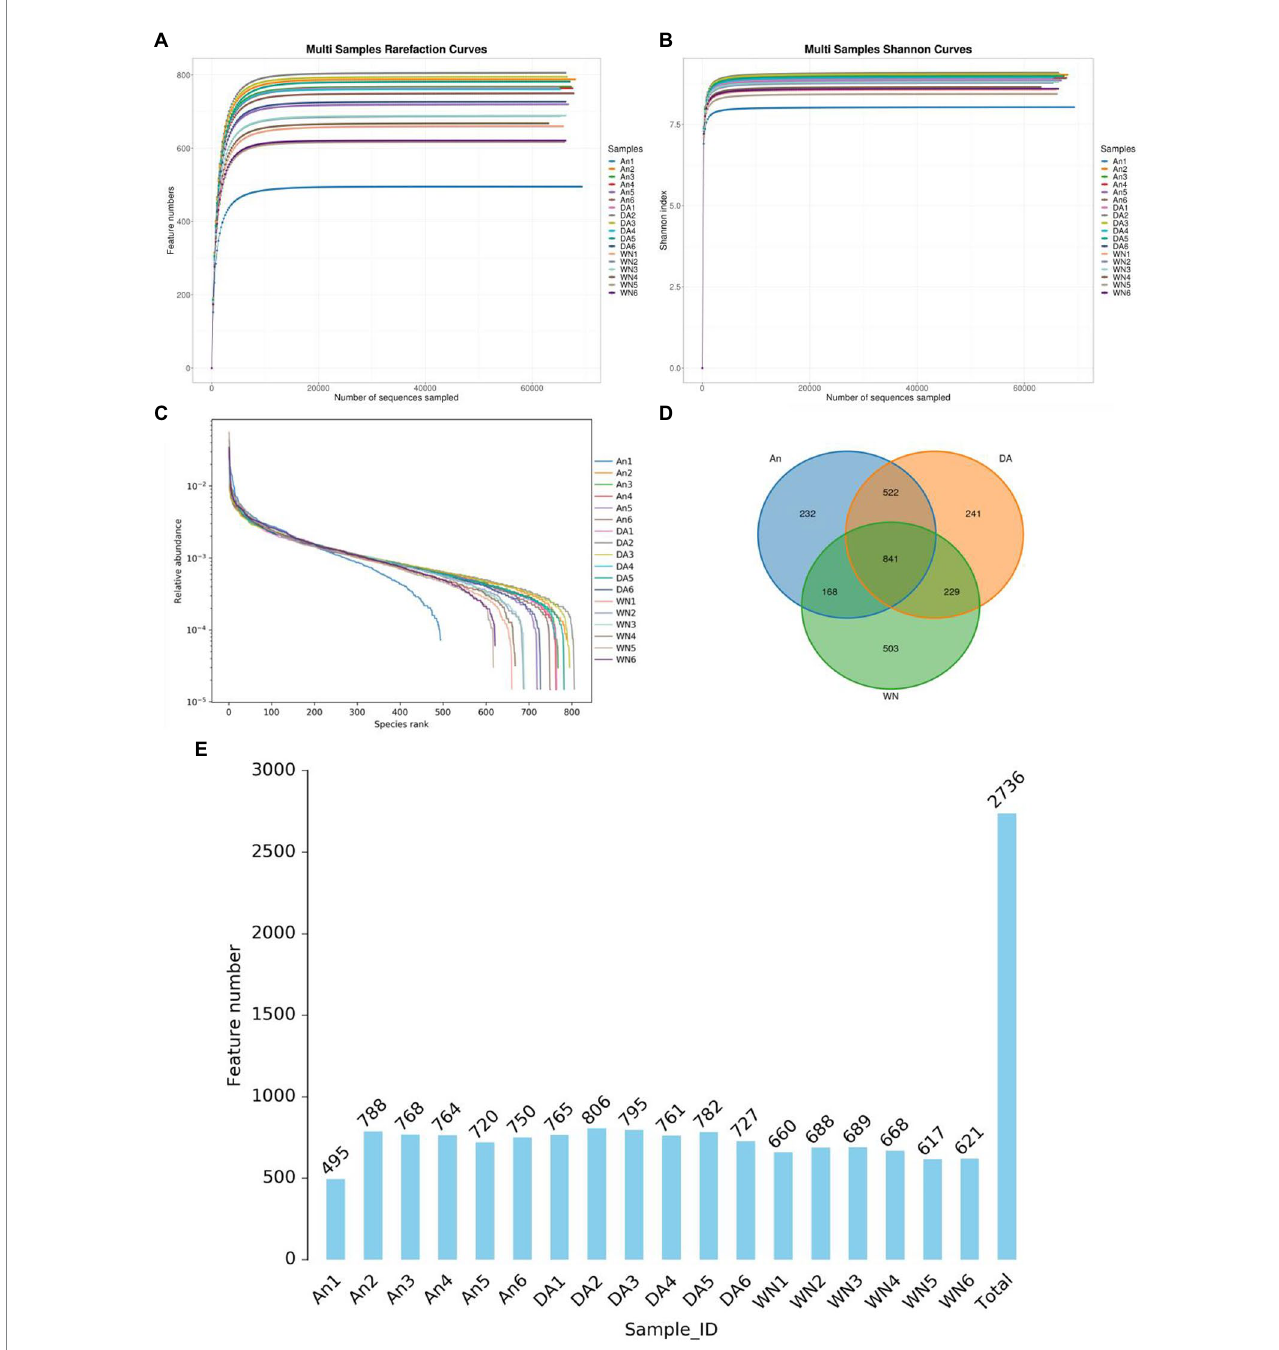
FIGURE 1 Feasibility analysis and OTUs distribution of amplicon sequencing. (A,B) Rarefaction curves. (C) rank abundance curves. (D) Venn diagram. (E) The numbers OTUs in each